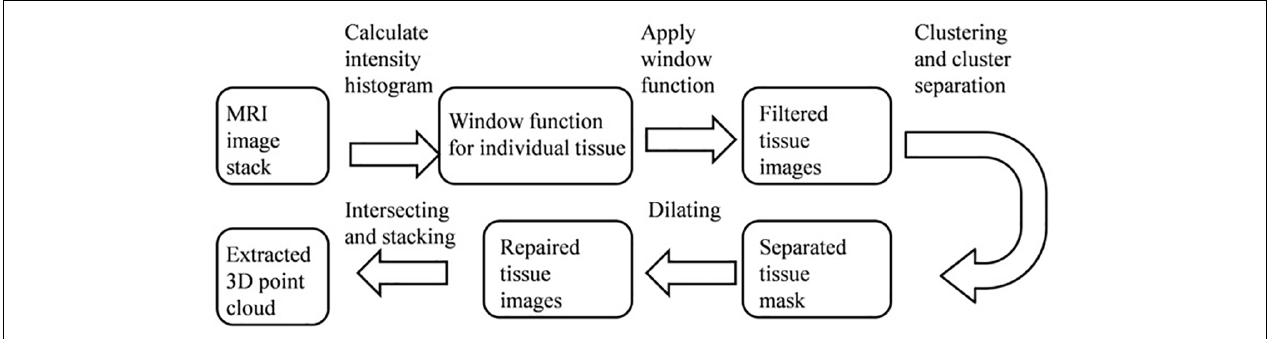
FIGURE 2 | A block diagram showing the steps to extract the 3D point clouds of individual tissue from an MRI image stack.